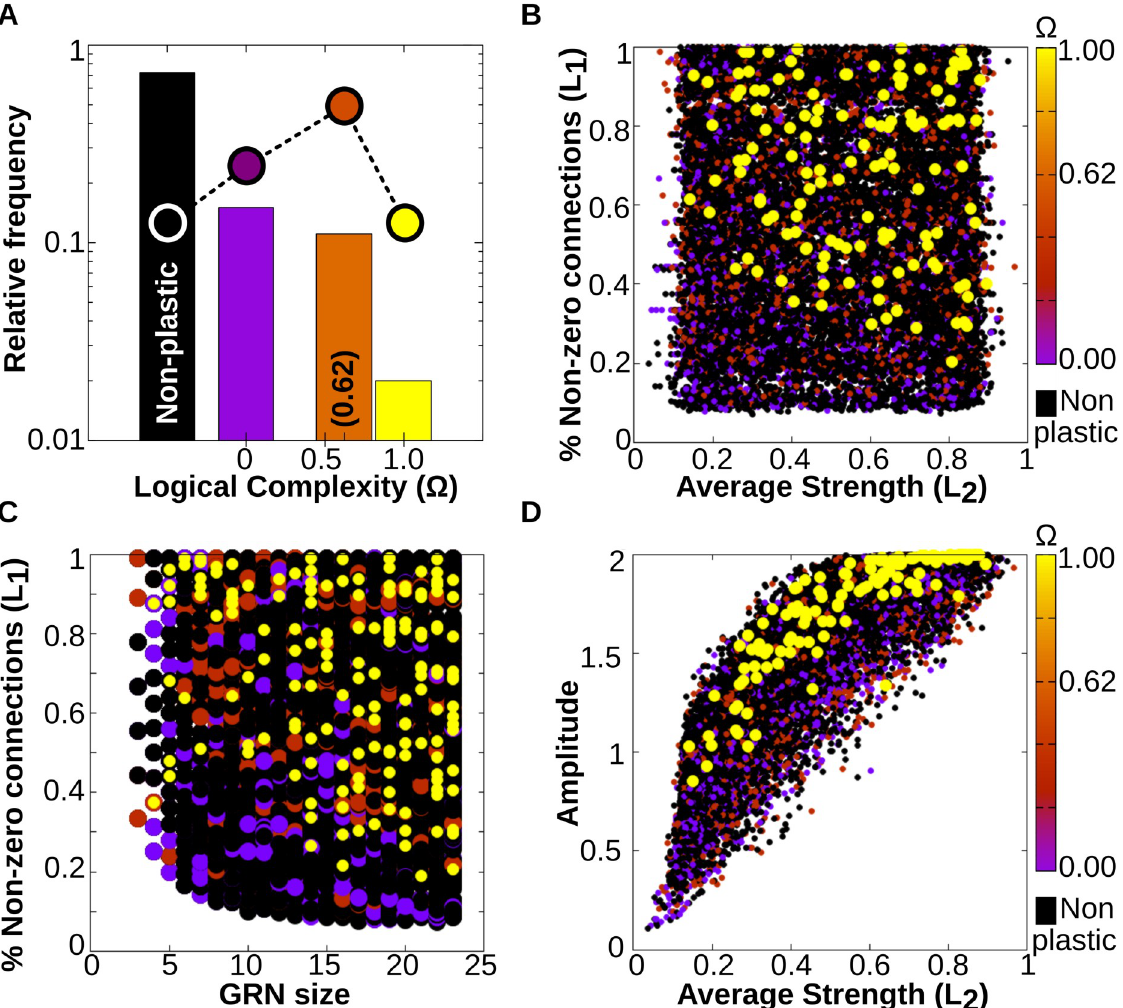
Fig 4. Exploring the morphospace of cell plasticity. A. (Log) Relative frequency of different types of cell plasticity according to their complexity Ω in a vast GRN space. Black column: no plasticity (the phenotypic state is purely determined by genes); purple column: phenotypic state directly determined by just one of the Ne environmental factors; orange column: phenotypic state determined by simple combinations of the Ne environmental factors (linearly decomposable functions) and yellow column: complex forms of cell plasticity associated with non-linearly decomposable functions (XOR, XNOR; see SI). Dashed line and dots represent the relative distribution of each family of logical functions in the mathematical space. We see that although the number of simple and complex functions that exist is approximately equal, GRNs produce simple functions much more often. B. Complex forms of plasticity (yellow dots) arise preferentially in densely connected networks with strong gene-gene interactions. C-D. Complex forms of plasticity require minimum GRN sizes and disparate (0 << | B < 1) values in the GRN connections. In B-D panels, the % of non-zero connections and the average strengths of the GRNs ij | correspond, respectively, to the parameters L 1 and L 2 used for regularisation procedures (see Eqs 9 and 10). In general, less complex functions with Ω < 1 are evenly distributed in the parameter space, and are not associated with specific GRN topologies. ( Ne = 2; � 10 5